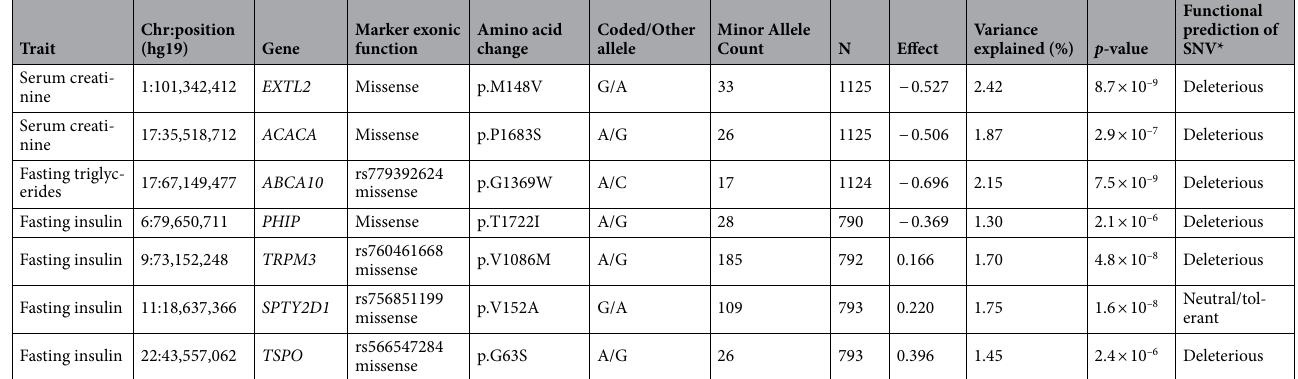
Table 1. Main association results for variant-trait significant findings. For nonsynonymous rare variants and LOF variants, functional prediction algorithms were used to classify a SNV as deleterious based on agreement for at least three algorithms of prediction methods (see methods and Table S3). All SNVs listed in Table 1 had a CADD Phred score > 10–20, which is considered deleterious, except for rs756851199. Models adjusted for age, sex, center, and the first 10 principal components of ancestry. Fasting insulin was tested among non- diabetic individuals in models additionally adjusted for BMI. Amino acid change provided by the Variant Effect Predictor tool. N total number of participants. N/A, not available. Note three SNVs are not present in a publicly available database and lack rs#. Significance threshold p = 4.9 × 10 –6 is based on number of SNVs and phenotypes tested.